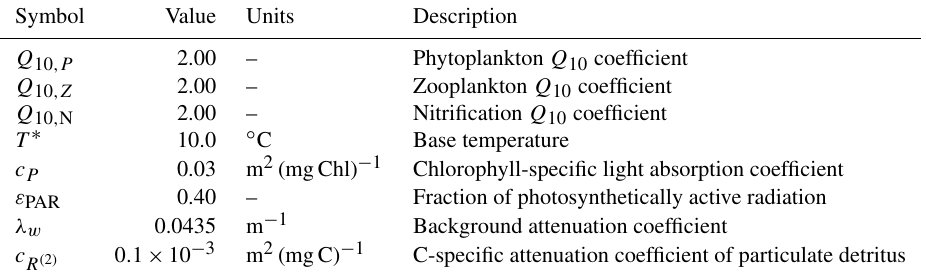
Table A1. Symbols, values, units, and descriptions for environmental parameters within the BFM17 pelagic model. Symbol